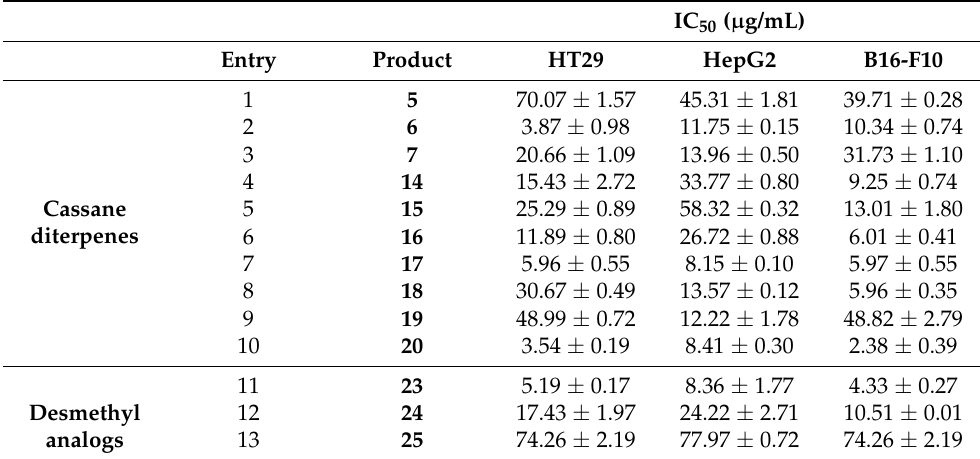
Table 3. Cytotoxic effects of the synthesized cassane diterpenoids and the 14-desmethyl analogs on the three cancer cell